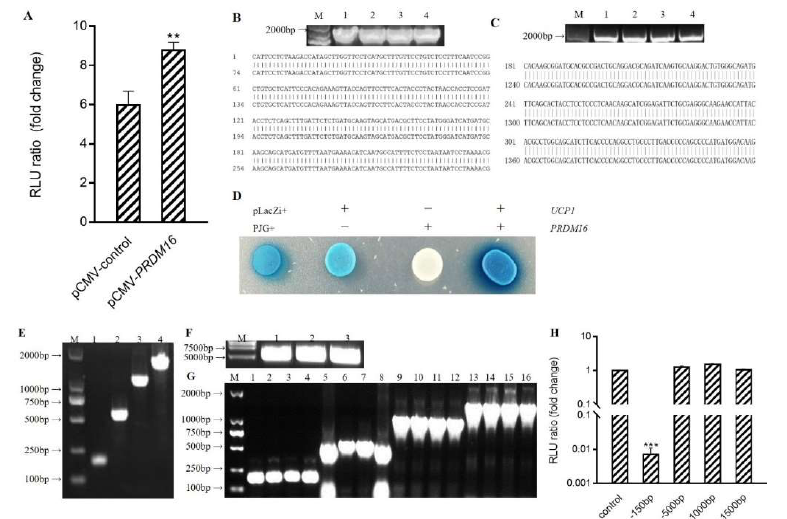
Figure 3. Overexpression of Prdm16 upregulates Ucp1 gene expression in brown adipose cells ( A ) Clone Prdm16 electrophoretic map,M: Kang Wei 200B PLA DD;Lane 1–8: Prdm16 amplification product. ( B ) PCR electrophoresis diagram of pCMV-Prdm16 bacterial solution;M: Kang Wei 200B PLA DD;Lane 1–11: PCR products from the picked bacterial solutions of 11 single colonies. ( C ) Com- parative diagram of pCMV-Prdm16 sequencing results. ( D ) Effect of overexpression of Prdm16 on Ucp1 gene expression C3H10T12 cells. ( E ) Effects of shPRDM16 on Ucp1 gene expression during C 3 H 10 T 1/2 cell differentiation. Compared with control, ** means p<0.01.